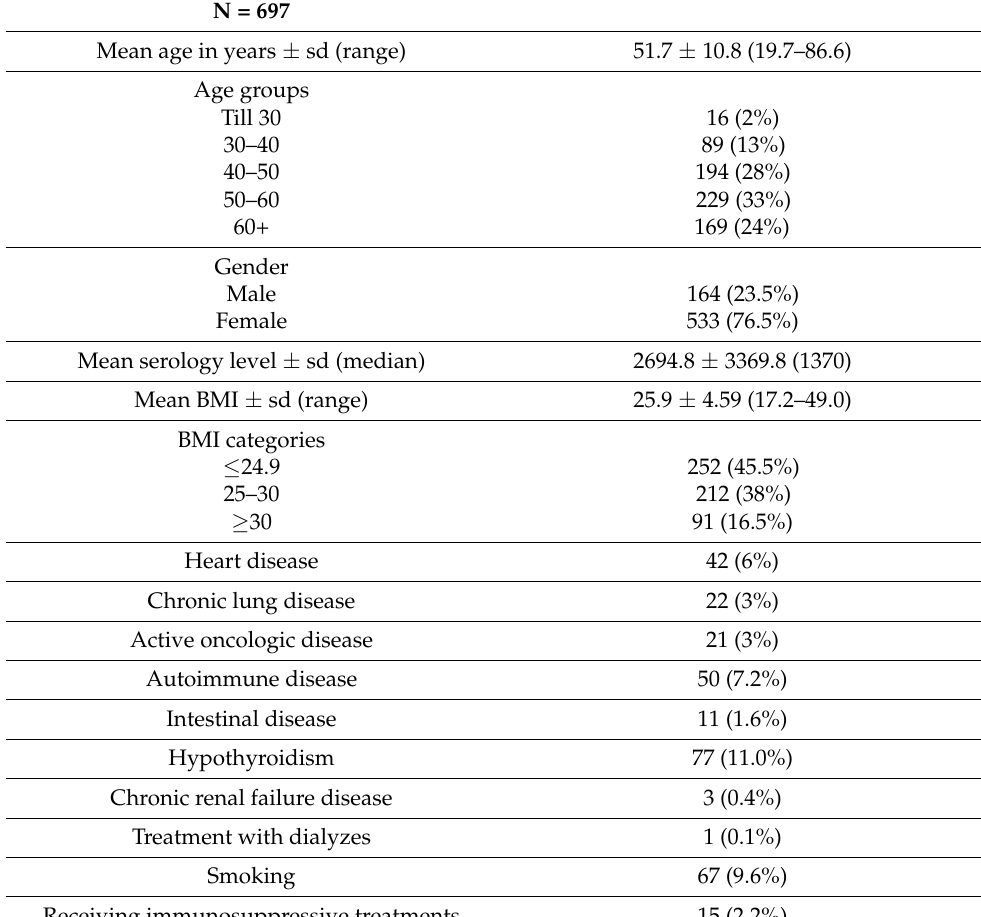
Table 3. Characteristics of participants who went through the 6th serology test in June